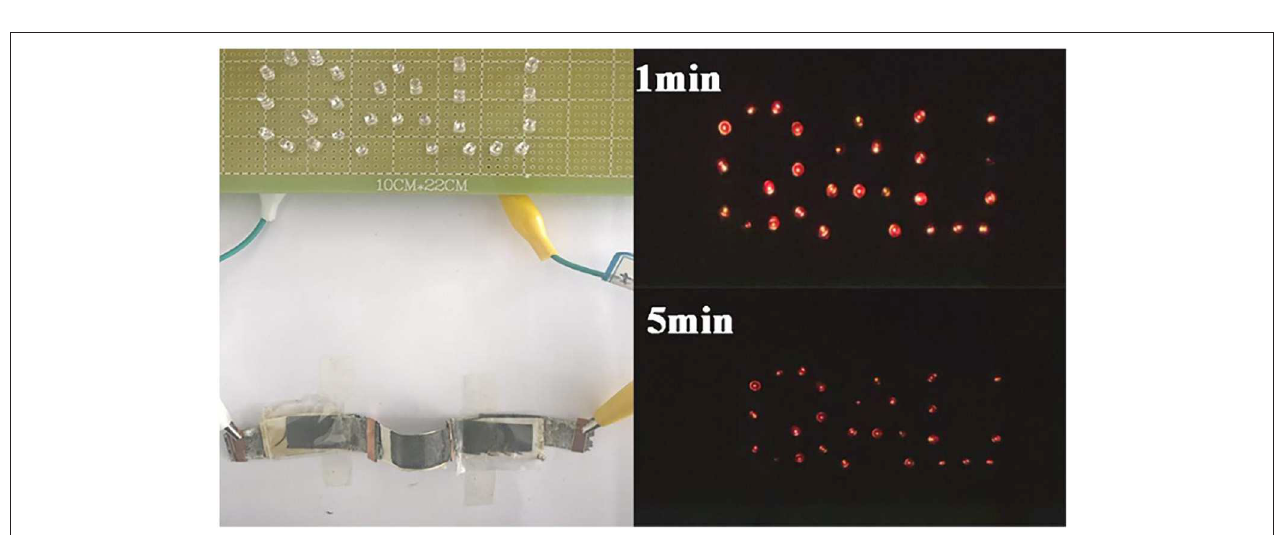
FIGURE 6 | Cycling properties of the device at 10 A · g − 1 (A) ; Ragone plot (B) ; images of asymmetric device at different bending states (C) ; and the corresponding CV curves (D) .